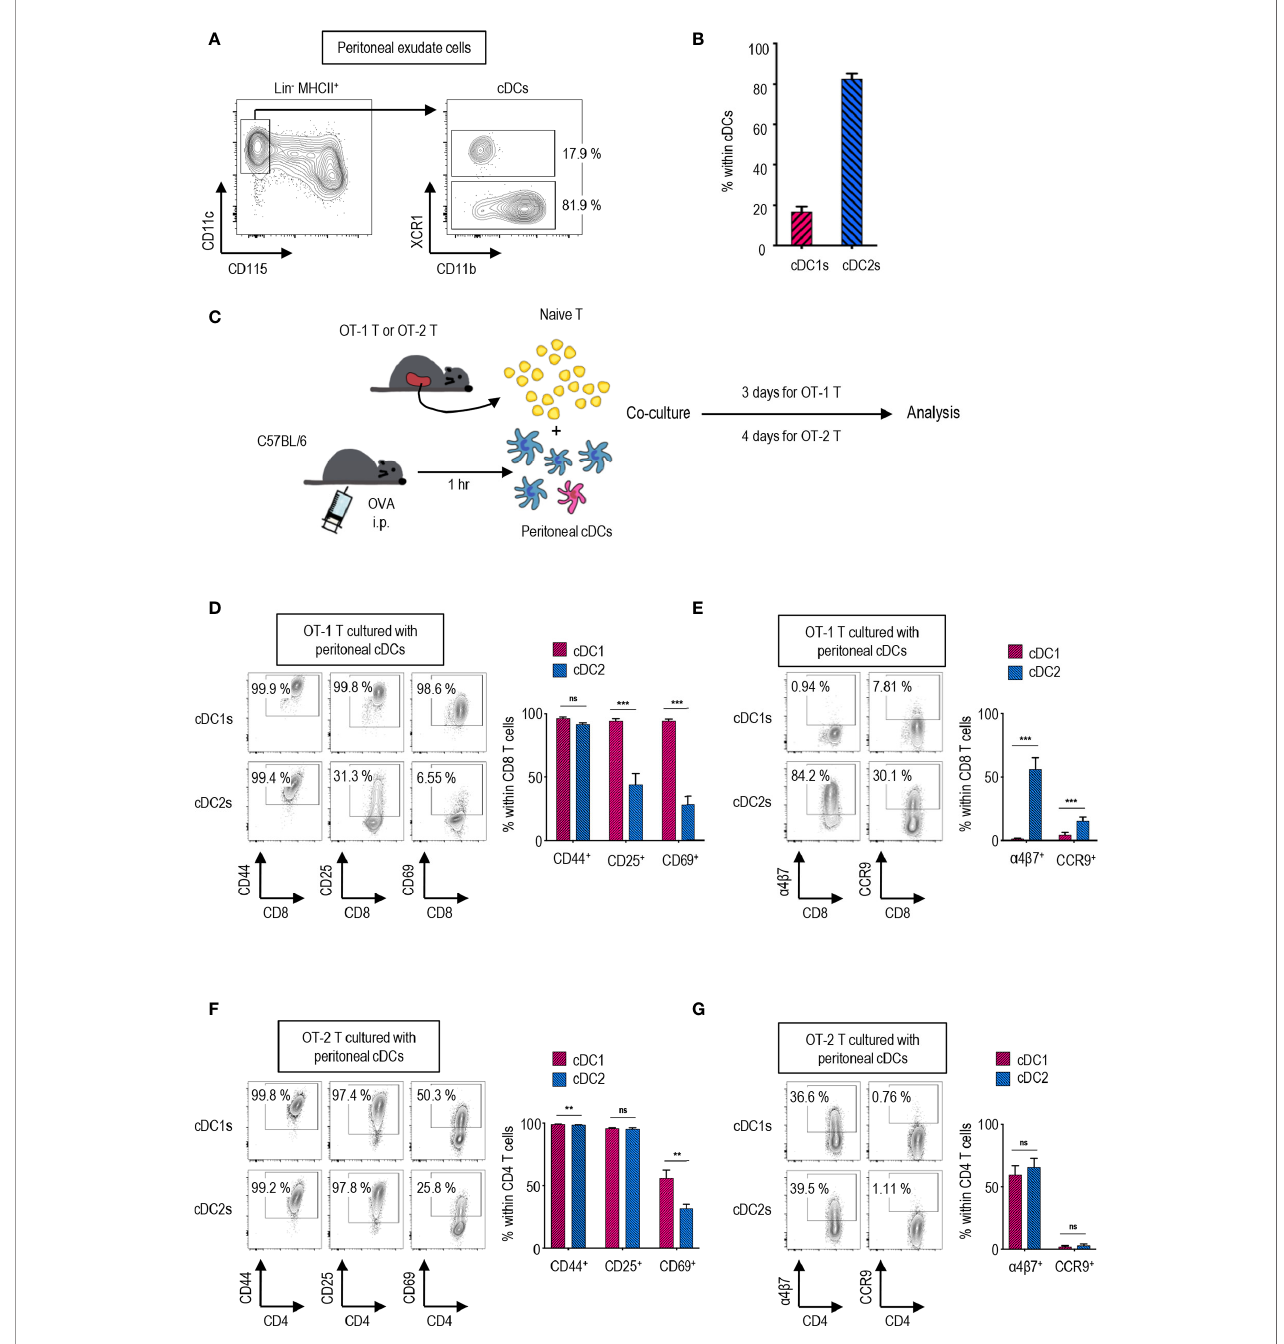
FIGURE 1 | Peritoneal cDC subsets induce distinct T cell responses. (A) Gating strategy of cDC subsets in the peritoneal cavity. Cells expressing Lin markers (CD3, CD19 and Ly6G) were excluded and cDCs were gated from MHCII + cells. The percentages of each subset among cDCs are shown (representative of 4 independent experiments). (B) The proportion of cDC subsets in the peritoneal cavity. The percentages of each subset among cDCs are shown in bar graph. Data are pooled from 4 independent experiments (n = 4). Error bars indicate mean ± SEM. (C) Experimental outline for CD8 (D, E) and CD4 (F, G) T cell responses. 1.5 mg of Ag (OVA, Grade V) was intraperitoneally (i.p.) injected. An hour later, OVA-laden peritoneal cDC subsets were isolated and co-cultured with either naïve OT-1 (CD8 + ) or OT-2 (CD4 + ) T cells in the ratio of 1:10 (APC:T). OT-1 T cells were analyzed on day 3, and OT-2 T cells on day 4. (D – G) CTV lo proliferated T cells are gated and shown. (D) Activation status of OT-1 T cells stimulated by peritoneal cDC subsets. Expression of CD44, CD25, and CD69 on OT-1 T cells stimulated by peritoneal cDC subsets are shown. (E) Expression of homing molecules, a 4 b 7 and CCR9, on OT-1 T cells stimulated by peritoneal cDC subsets. (F) Activation status of OT-2 T cells stimulated by peritoneal cDC subsets. Expression of CD44, CD25, and CD69 on OT-2 cells stimulated by peritoneal cDC subsets are shown. (G) Expression of homing molecules, a 4 b 7, and CCR9 on OT-2 T cells stimulated by peritoneal cDC subsets. Data in graphs are pooled from more than 4 (D, E) or 2 (F, G) independent experiments (n ≥ 5). Error bars indicate mean ± SEM. **p<0.01; ***p<0.001; ns, statistically not signi fi